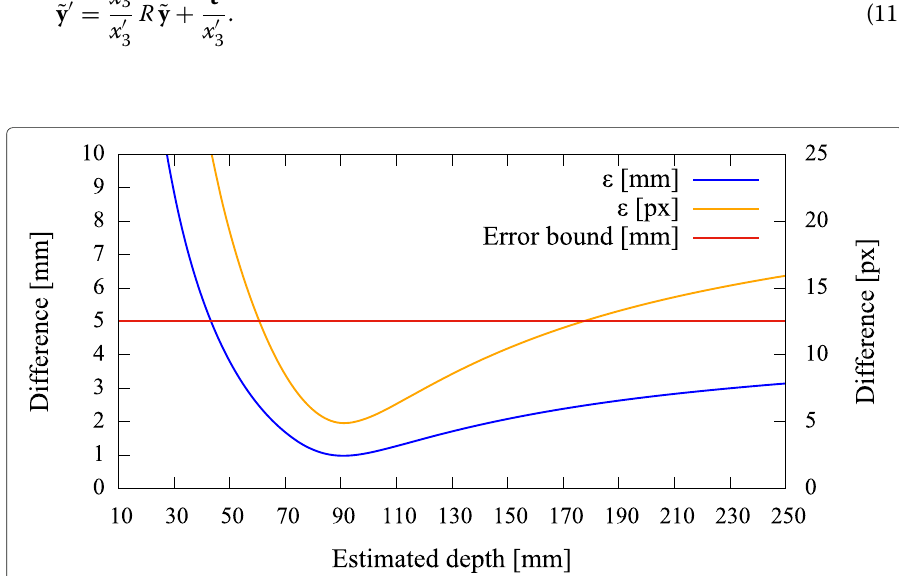
Fig. 15 Pair 2, true source distance 110 mm ( x 3 ), initial camera distance 109.8 mm ( x (cid:3) 3 ). Without automatic pose estimation, the error is lowest at the apparent depth of ≈ 90